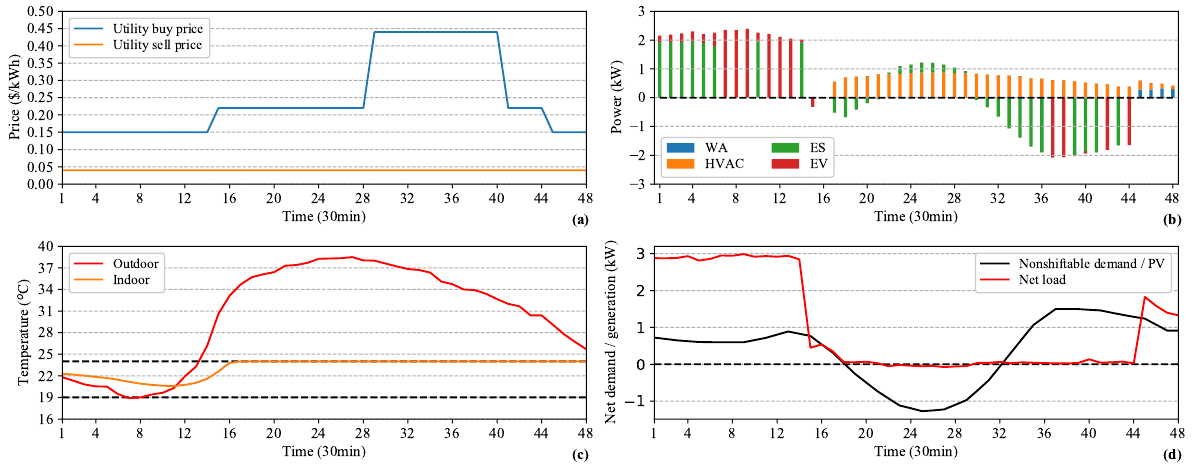
Figure 6. ( a ) Utility buy and sell prices, ( b ) aggregated schedule of flexible DERs, ( c ) indoor and outdoor temperature, and ( d ) net demand/generation of the household with/without flexible DERs for the investigated summer day under the TD3 method.